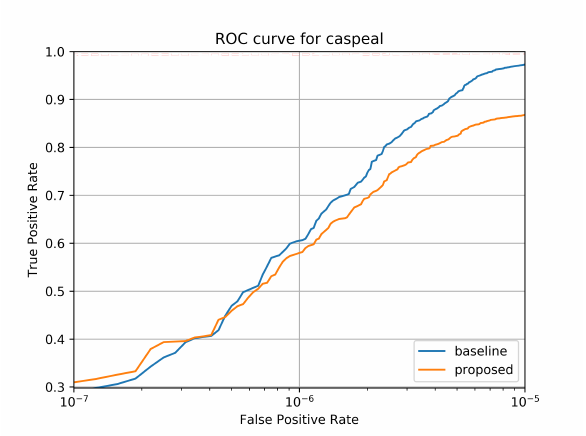
Figure 8. Face recognition on